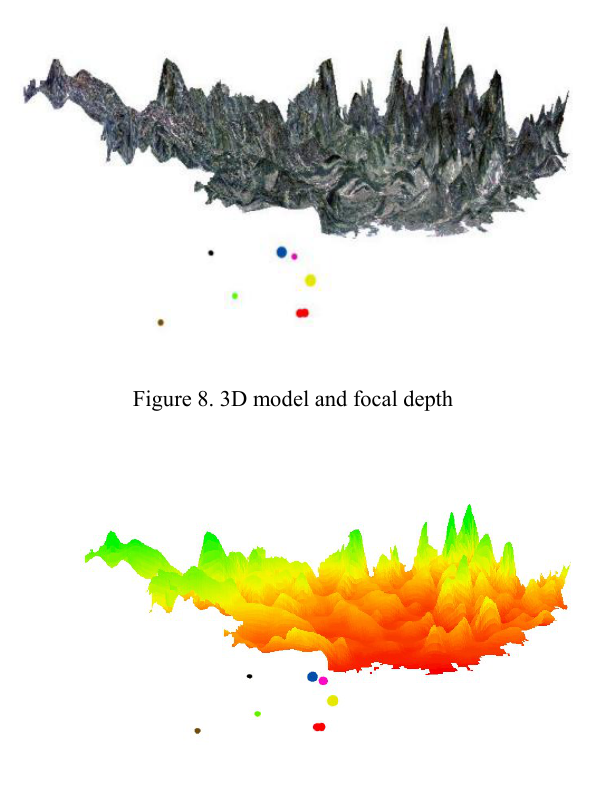
Figure 9. Three-dimensional model of elevation